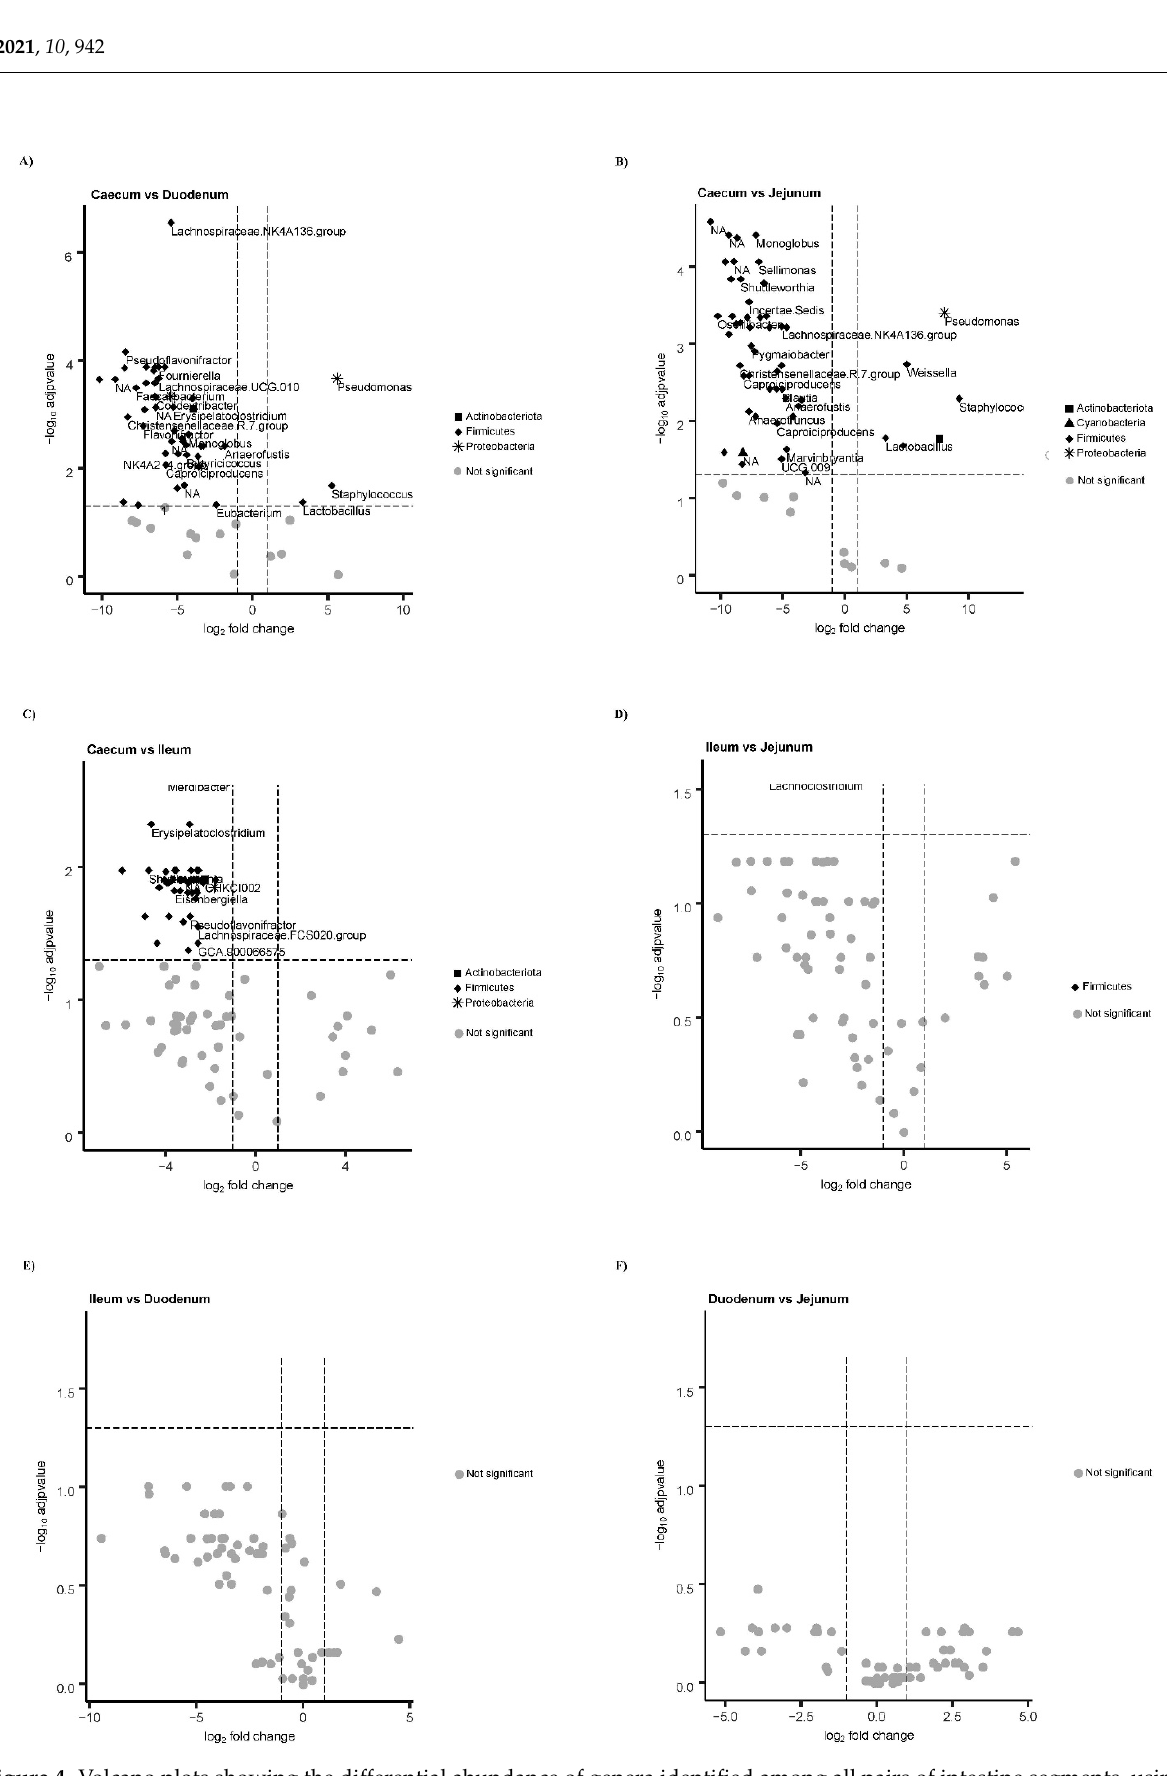
Figure 4. Volcano plots showing the differential abundance of genera identified among all pairs of intestine segments, using ANCOMII analysis. Significant cases (in black), with the indication of the phylum they belong to, are log fold change (log 2 FC) > or = 1. Not significant cases are in grey.